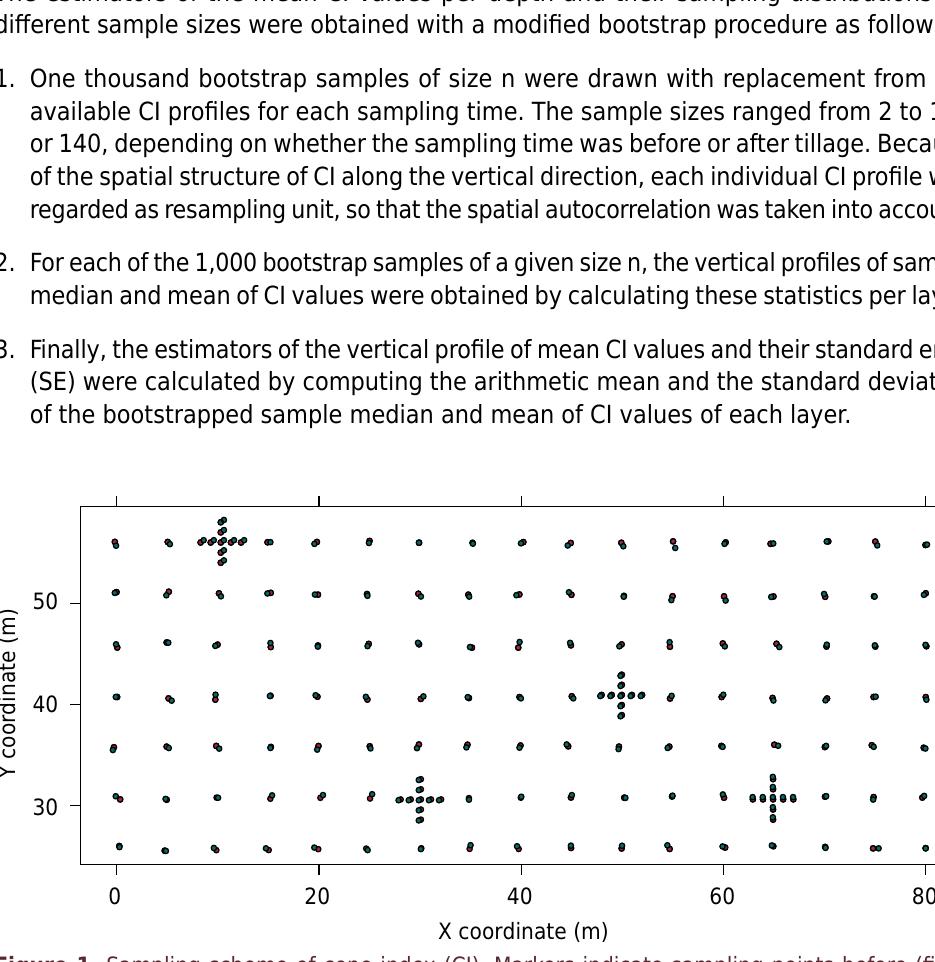
Figure 1. Sampling scheme of cone index (CI). Markers indicate sampling points before (filled circles) and after tillage (empty